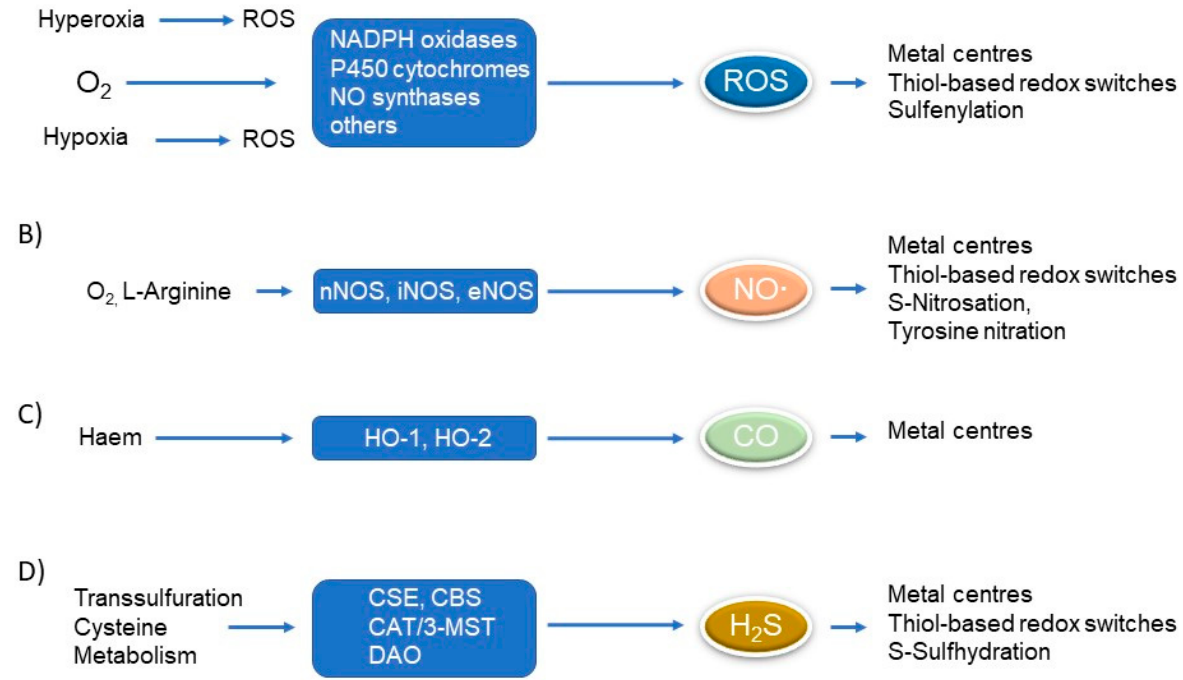
Figure 1. Synthesis and action of redox-mediators in mammalian cells. ( A ) Formation of ROS by the enzymatic activity of several oxidases. Note that enhanced ROS formation occurs during normoxia and is enhanced in a hyperoxic as well as hypoxic environment. ( B ) Generation of NO · by NO synthases. ( C ) Formation of CO by HO-1 and HO-2. ( D ) Synthesis of H 2 S via the transsulfuration pathway